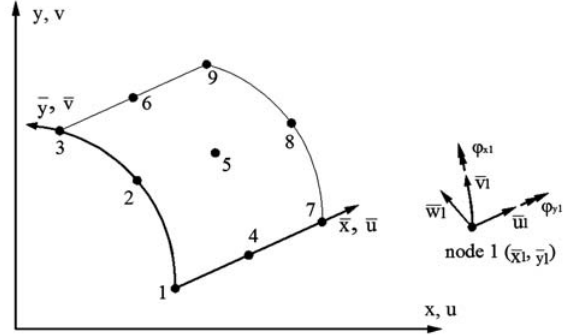
Figure A-1 A 9-node shell